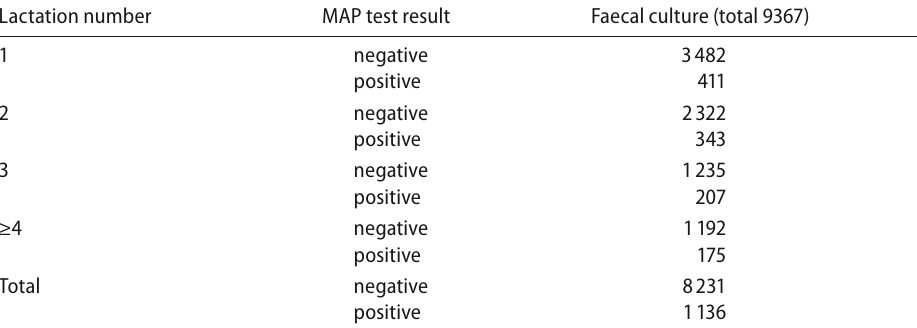
Distribution of animals per number of lactation, tested for MAP by faecal culture Lactation number